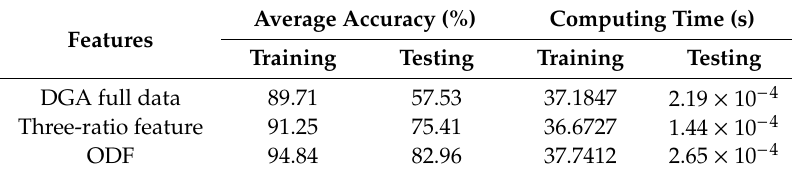
Table 7. Accuracy and computing time of each DGA feature.